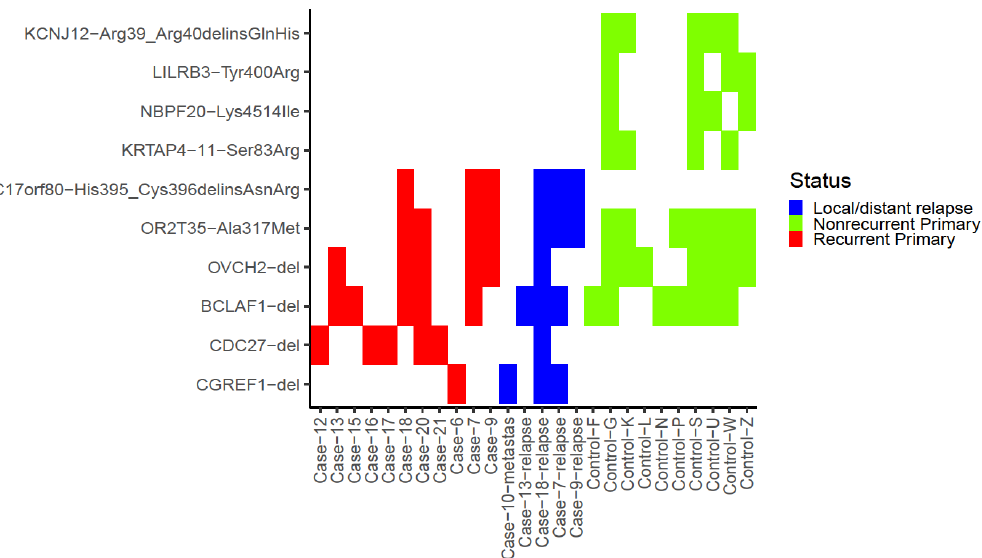
Figure 2. Heatmap of the most commonly occurring variants, variants specific to either primary of patients with local/distant recurrence (denoted as cases) or primaries of nonrecurrent patients (denoted as controls) and variants unique to relapses (denoted metastasis, if distant metastasis, or relapse, if local recurrence). Variants are on the y -axis, samples are on the x -axis. Colour indicates sample category. Samples where none of the variants were present were excluded from the plot.